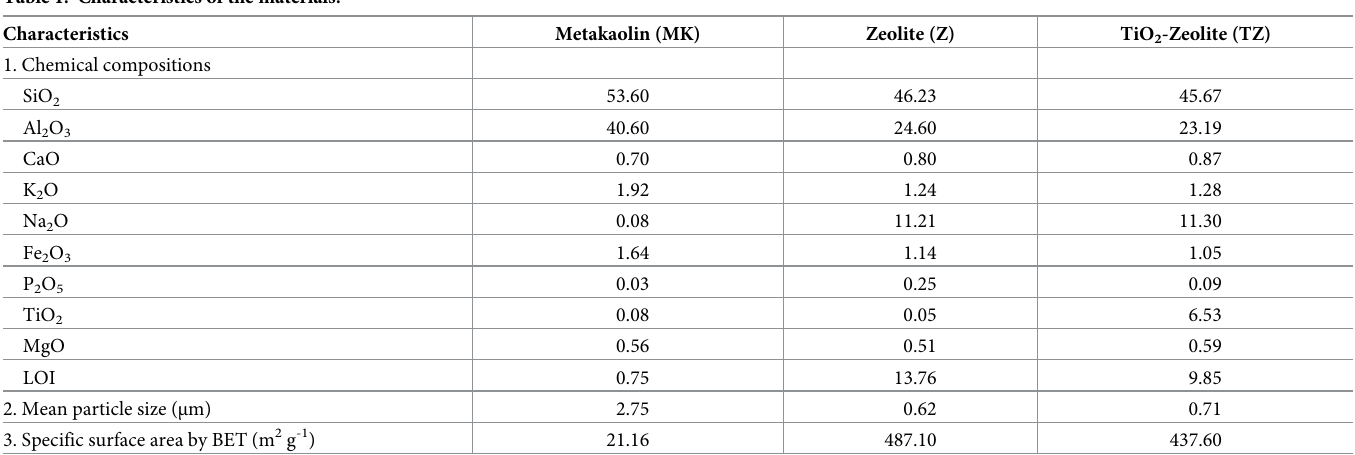
Table 1. Characteristics of the materials.